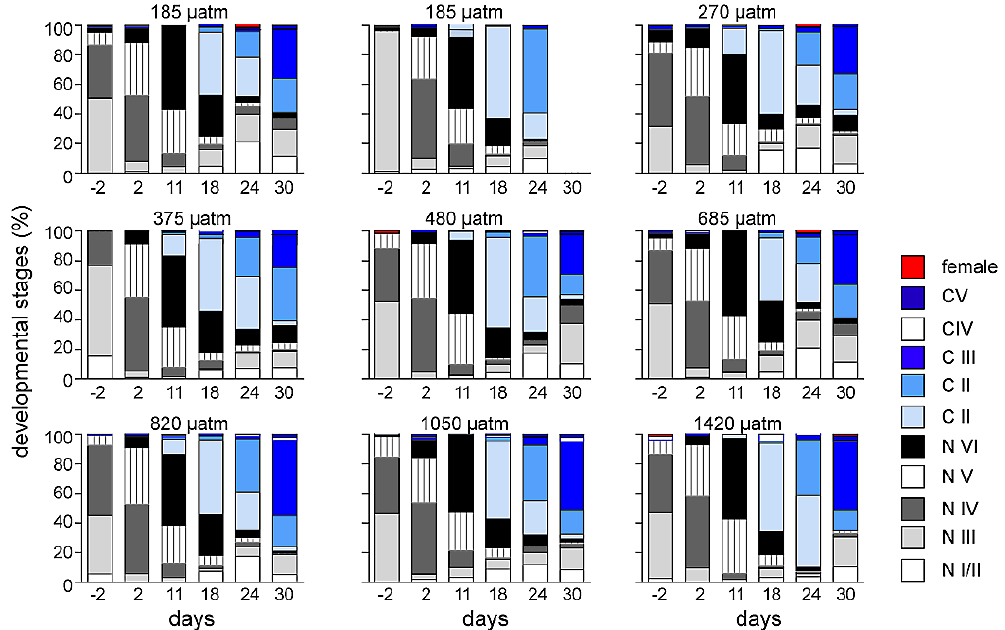
Fig. 10. Developmental stage distribution of Calanus spp. in the water column of the mesocosms: C=copepodite stage; N=nauplius stage; numbers on top of the panels present the initial CO 2 concentration in each mesocosm after the CO 2 manipulation was